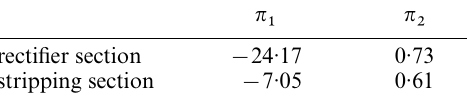
Table 2. Empirical parameters for equation (17)